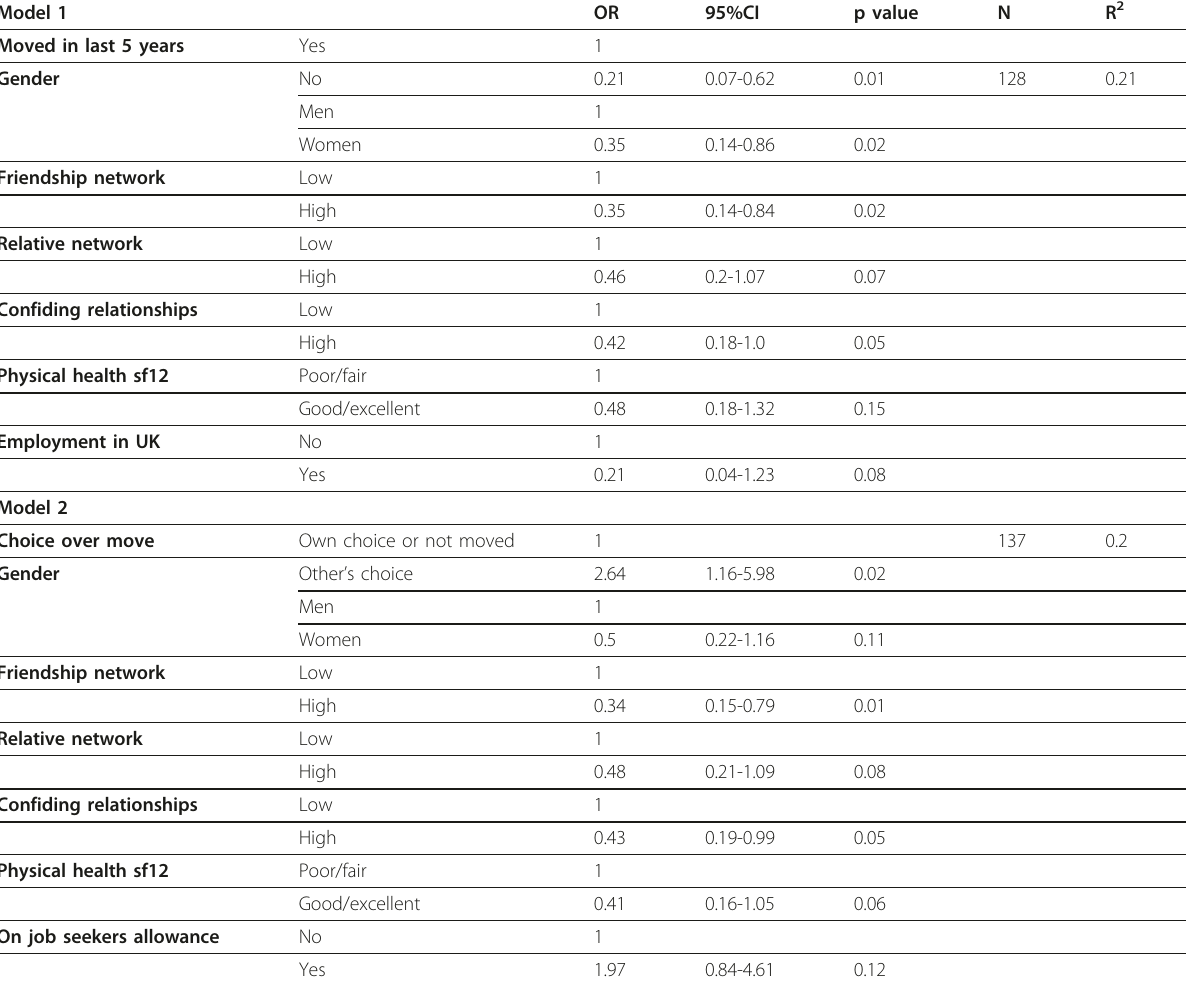
Table 4 Associations with psychiatric disorder from stepwise logistic regression models: only retained variables shown Model